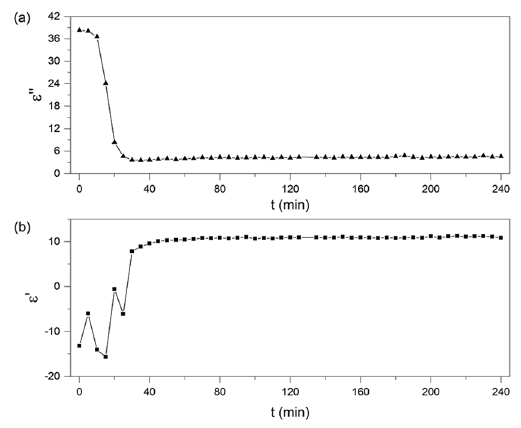
Figure 9. (a) Dielectric loss factor ε'' and (b) dielectric constant ε' of the Araldite ® LY5052/Aradur5052 TM epoxy system under isothermal cure at